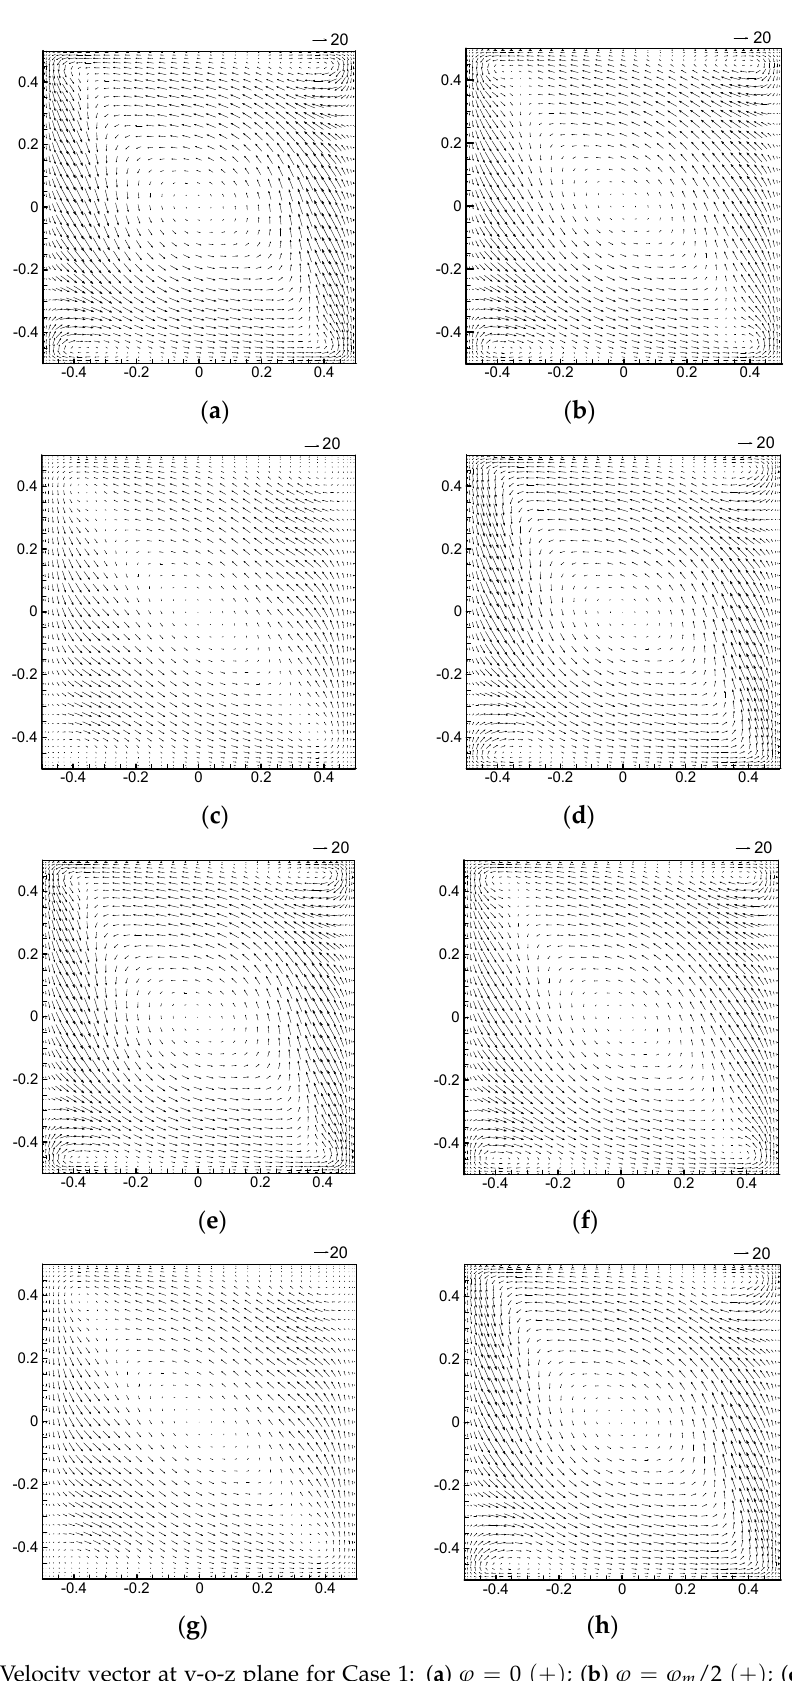
Figure 7. Velocity vector at y-o-z plane for Case 1: ( a ) ϕ = 0 (+) ; ( b ) ϕ = ϕ m /2 (+) ; ( c ) ϕ = ϕ m ; ( d ) ϕ = ϕ m /2 ( − ) ; ( e ) ϕ = 0 ( − ) ; ( f ) ϕ = − ϕ m /2 ( − ) ; ( g ) ϕ = − ϕ m ; ( h ) ϕ = − ϕ m /2 (+)